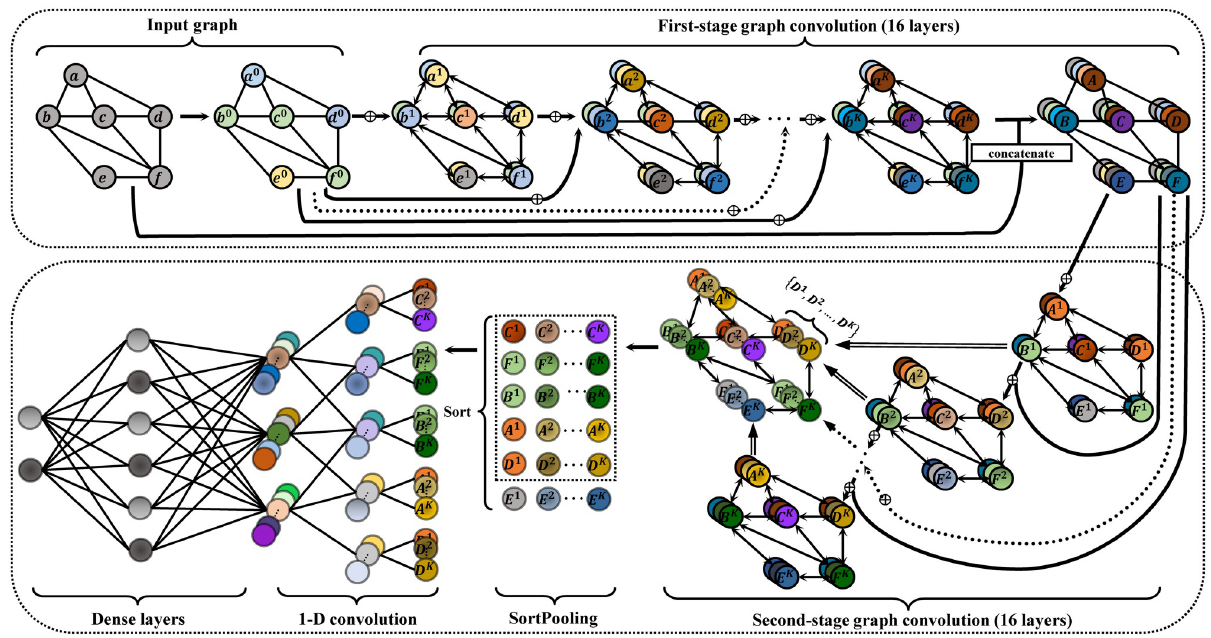
Fig 2. The overall structure of DGCNNII. The input graph with arbitrary structure first obtains the fine high-dimensional node features through the 16 layers of graph convolution in the first-stage, and then inputs them into the 16 layers of graph convolution in the second-stage, and the high- dimensional node features propagate deeply among the neighbors. Finally, the SortPooling layer is used to sort and intercept the nodes, and transfer them to the common convolution layer and dense layer for graph classification model training. Features are visualized as colors.